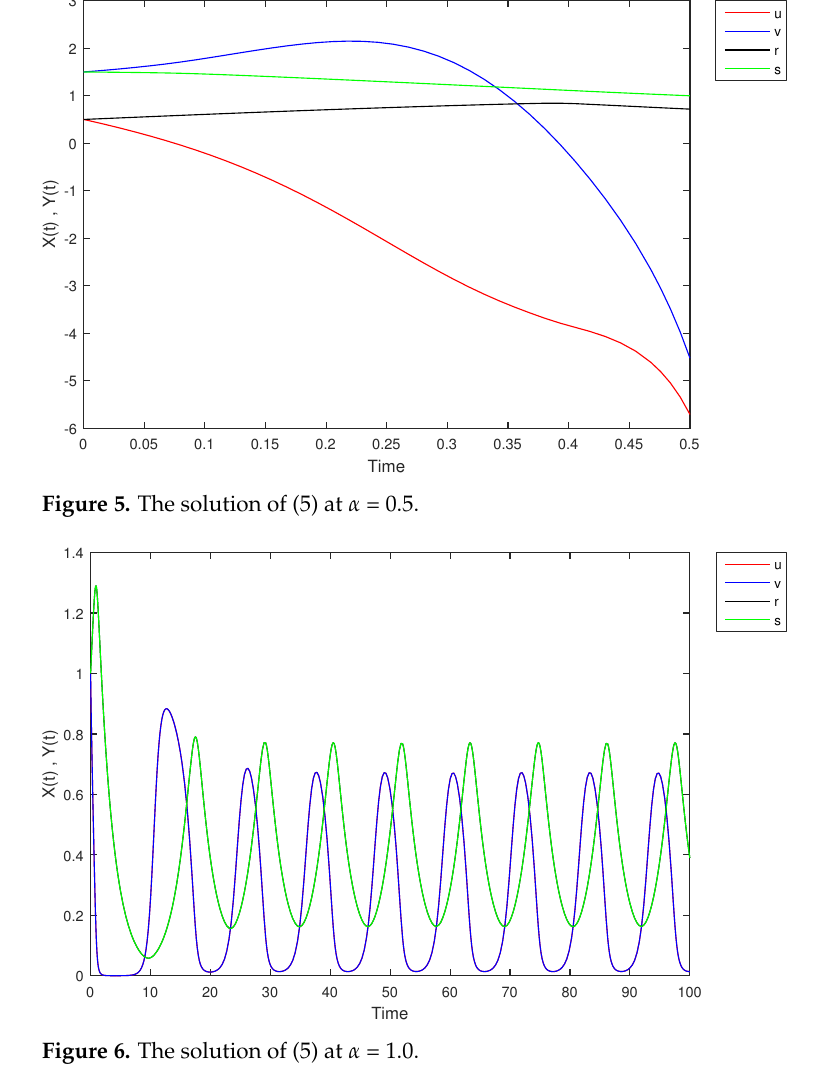
Figure 6. The solution of (5) at α =